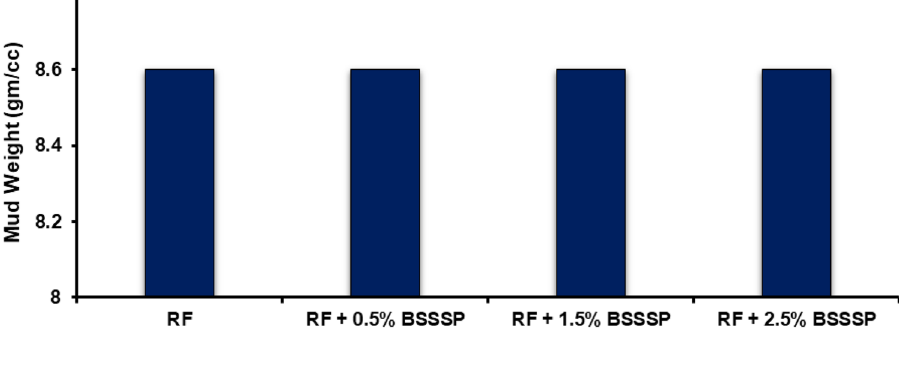
Fig. 13 The effects of BSSSP on the marsh funnel viscosity (fresh